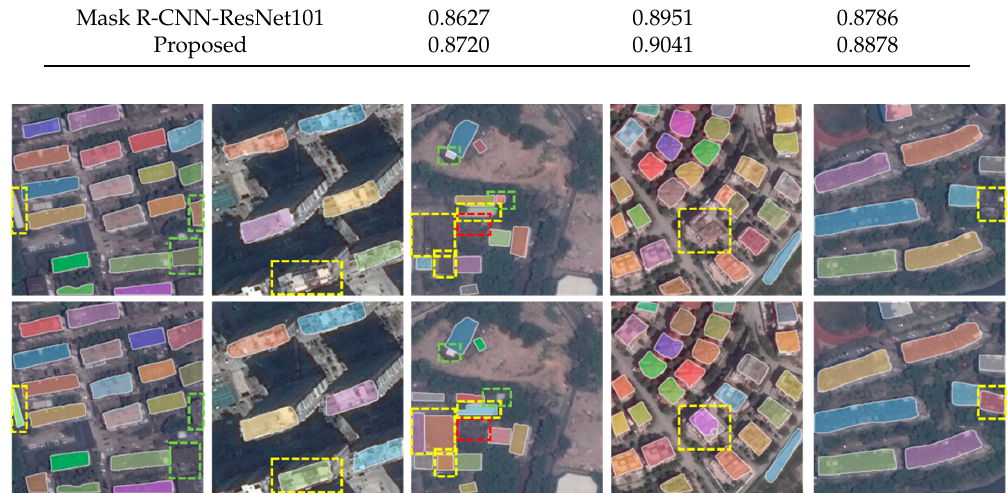
Figure 9. Building segmentation results. The first row shows results obtained by the Mask R ‐ CNN ‐ ResNet101, and the second row is the results of our method. Regions within yellow dashed lines are buildings successfully segmented by our method while missed by the Mask R ‐ CNN ‐ ResNet101. The green dashed lines indicate results obtained by the Mask R ‐ CNN ‐ ResNet101 while missed by our method. Red dashed lines are the results missed by both methods. As can been seen, our method obtains results better than Mask R ‐ CNN ‐ RnsNet101 in most case.